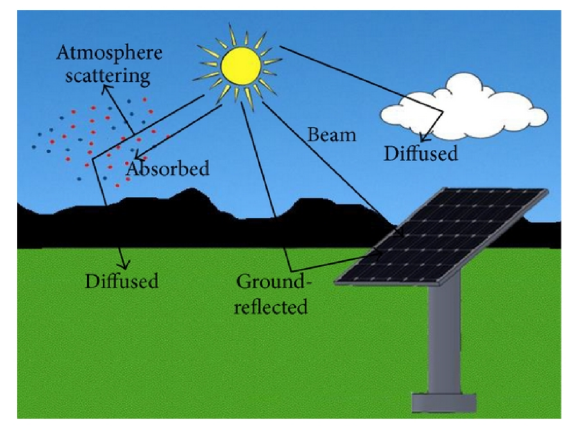
Figure 1. Components of global irradiation, source: (Lee et al., 2013)